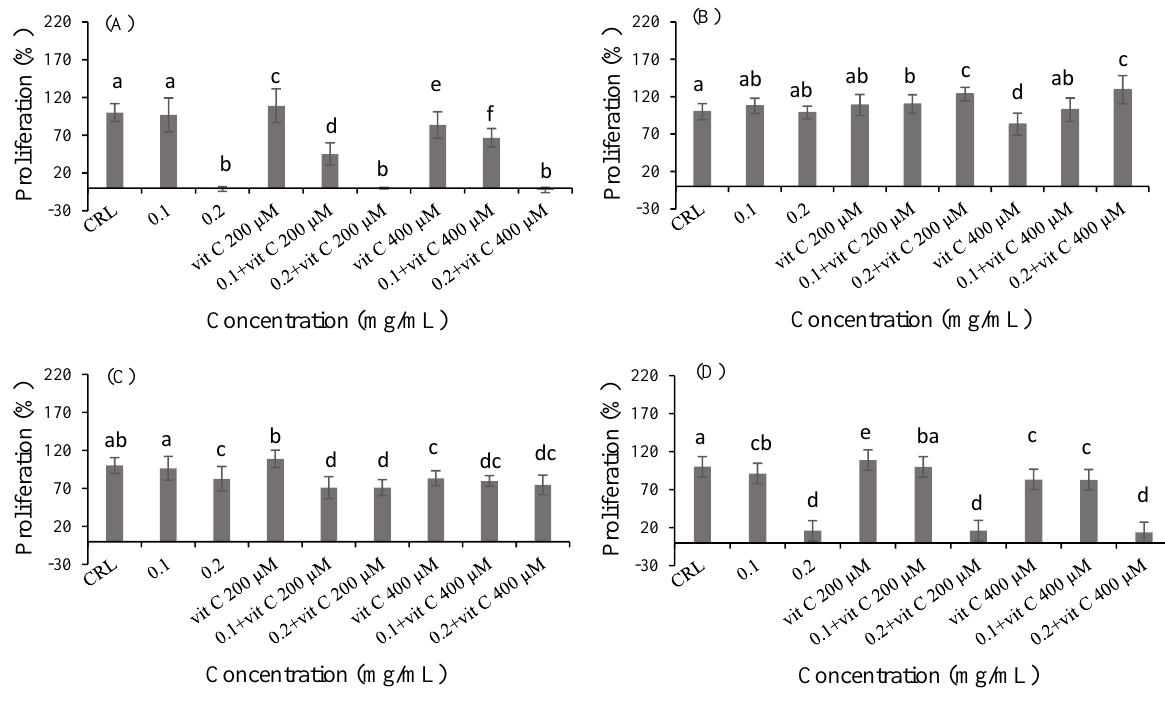
Figure 2. Protective effect of vit C (200 and 400 µM) on the bioaccessible fractions (0.1 and 0.2 mg/mL) of product 1 ( A ), product 2 ( B ), product 3 ( C ) and collagen ( D ) in Caco-2 cells after 24 h of exposure as assessed by the MTT assay. Values are expressed as mean ± SEM ( n = 3). Values in the same figure with different superscript letters are significantly different ( p < 0.05). CRL: control.